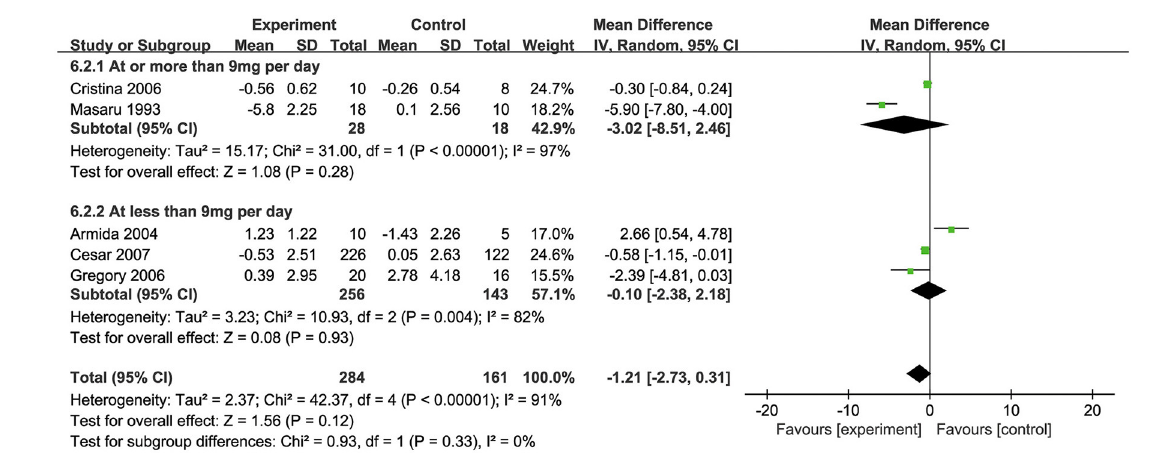
FIGURE3 Effects of biotin supplementation on FBG levels < or ≥ 9 mg/d.